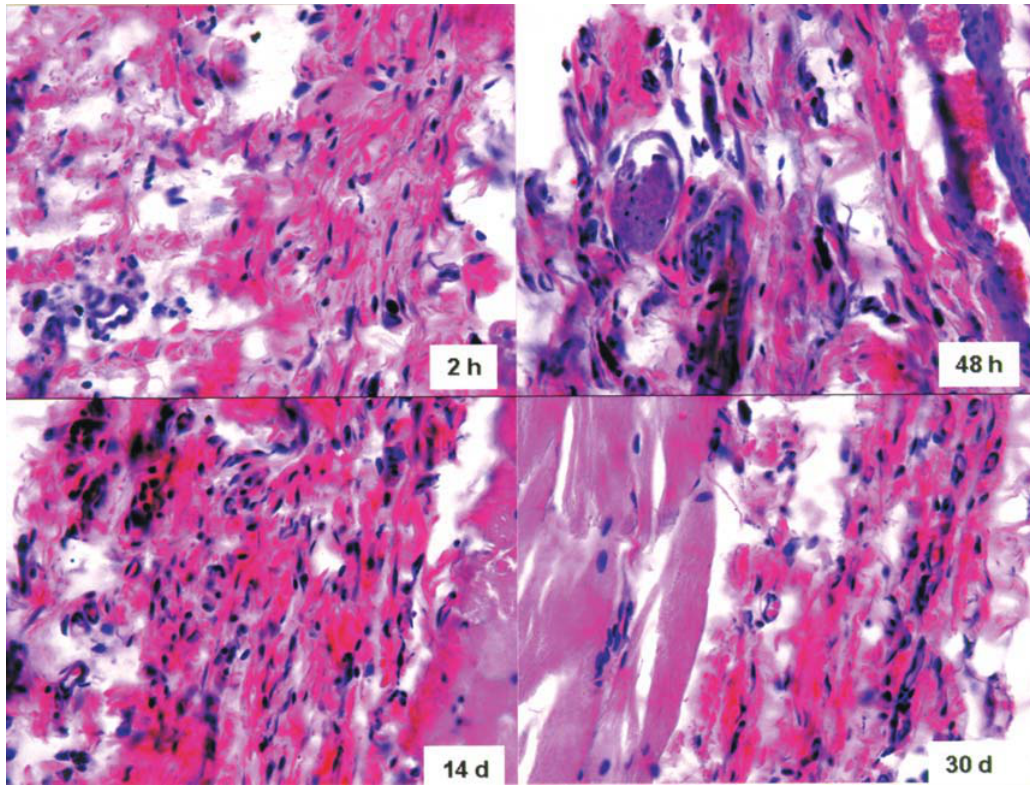
FIGURE 2 - Reaction of rat subcutaneous connective tissue to 0.9% sterile saline (H.E.;